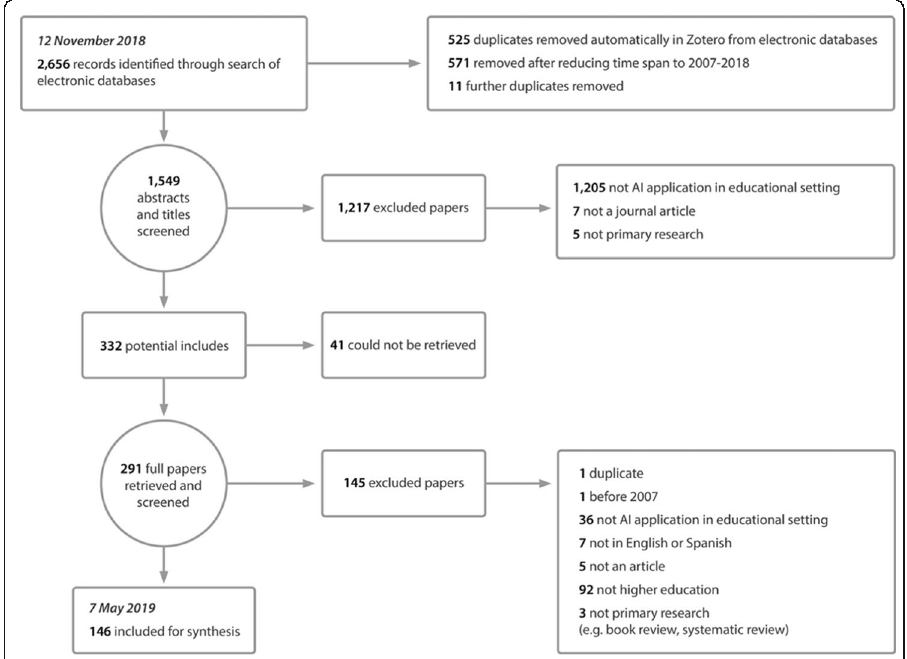
Fig. 1 PRISMA diagram (slightly modified after Brunton & Thomas, 2012, p. 86; Moher, Liberati, Tetzlaff, & Altman, 2009, p.